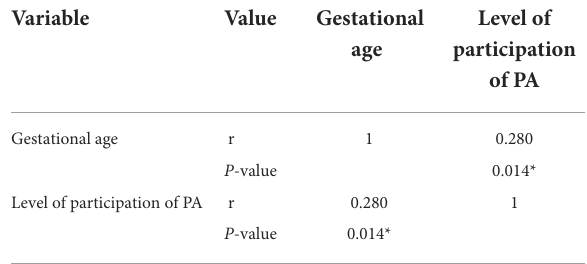
TABLE 6 Correlation analysis between the level of participation of PA and gestation age of pregnant